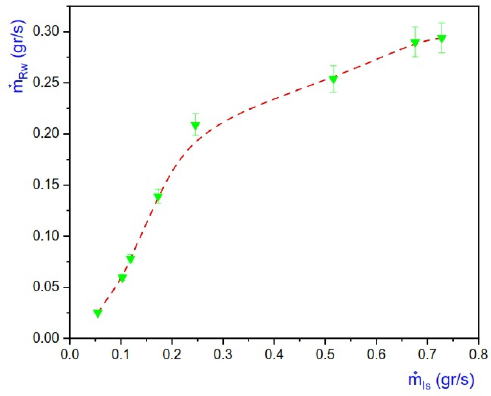
· m R as a function of the mass flow rate of